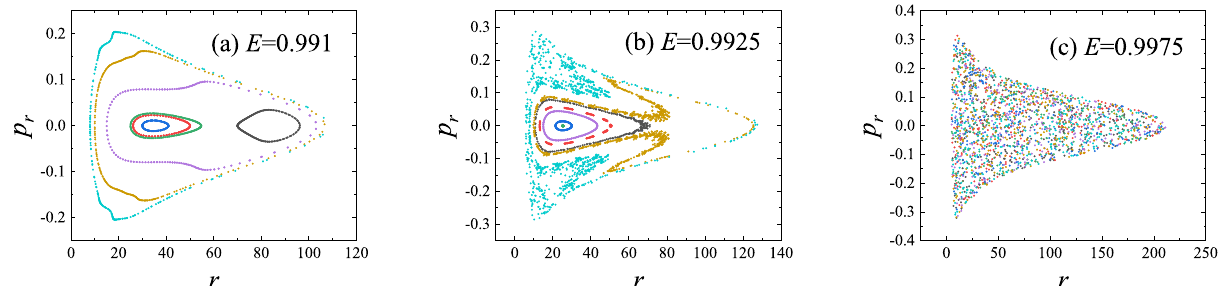
Figure 2. Poincaré sections. The parameters are the same as those in Figure 1c, but Q = 8 × 10 − 4 , k 0 = 10 − 4 and the energies E are different. The energies are ( a ) E = 0.991, ( b ) E = 0.9925 and ( c ) E = 0.9975. The three sub-figures show that the chaoticity becomes strong as the energy increases.